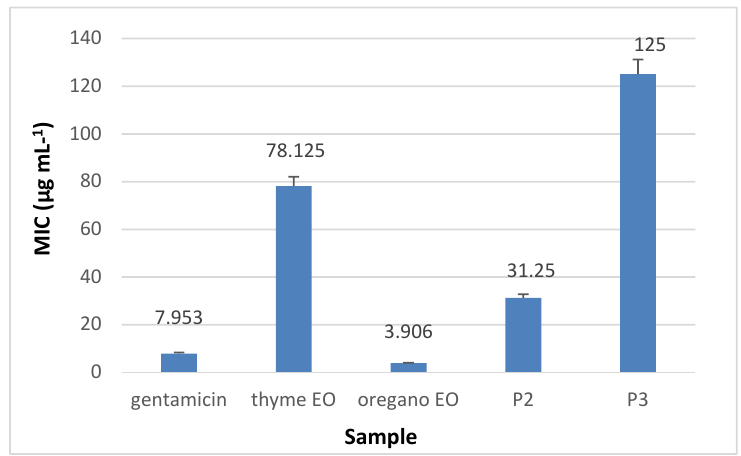
Figure 10. Minimum inhibitory concentration (MIC) of collagen nanofibres loaded with essential oils against S. aureus ATCC 25923, as compared to gentamicin and essential oils.